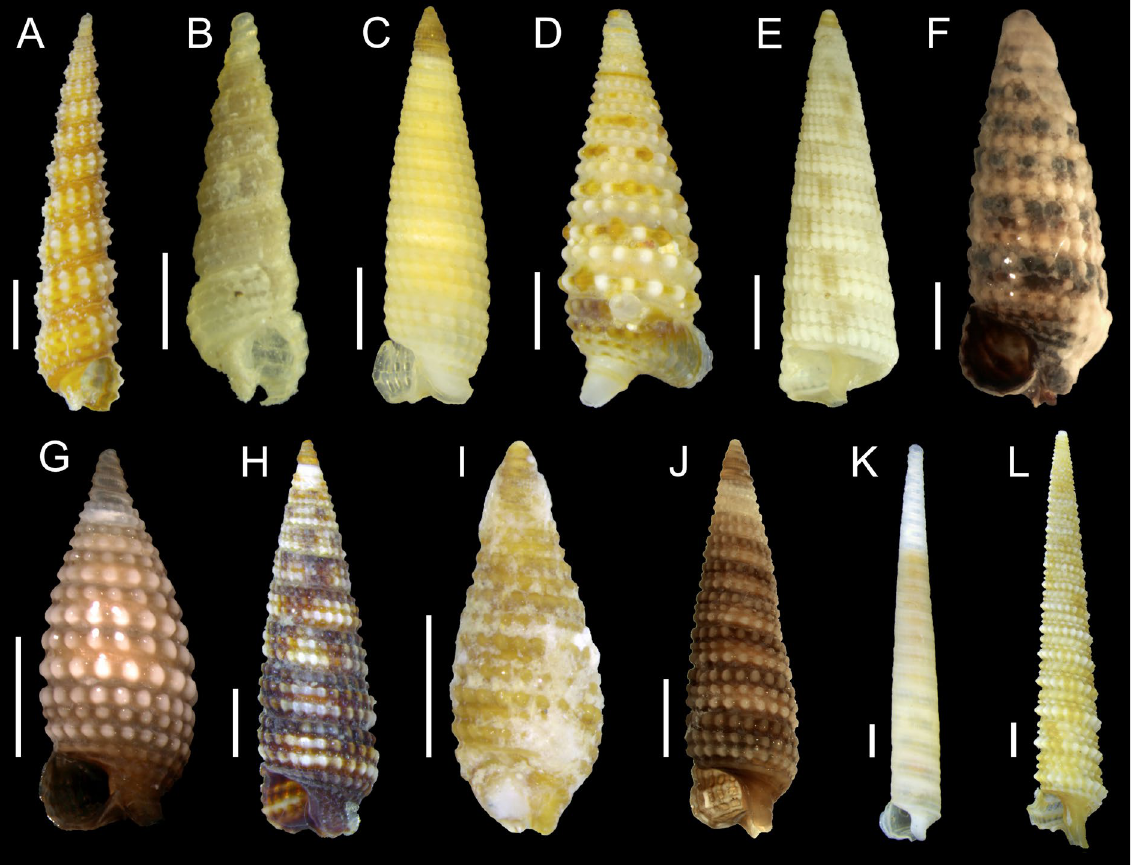
Fig. 2. Specimens studied. A . Metaxia excelsa Faber & Moolenbeek, 1991 (MZSP 122353). B .